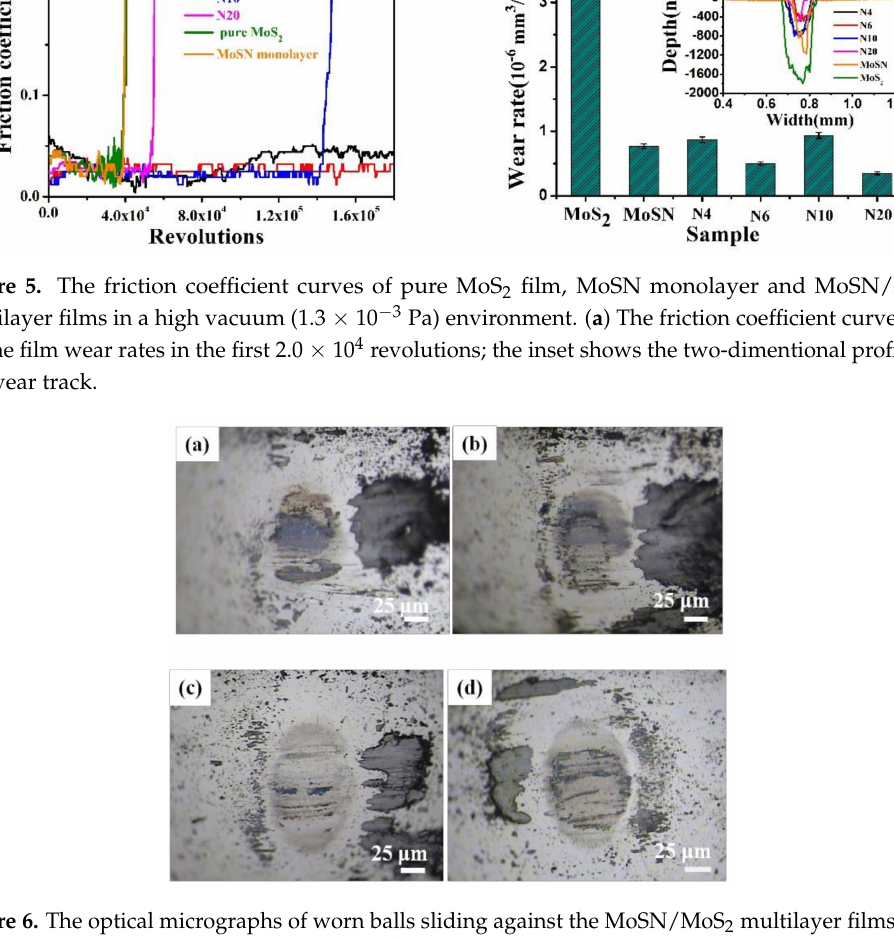
Figure 6. The optical micrographs of worn balls sliding against the MoSN/MoS 2 multilayer films of ( a ) N4, ( b ) N6, ( c ) N10, and ( d ) N20 for 2.0 × 10 4